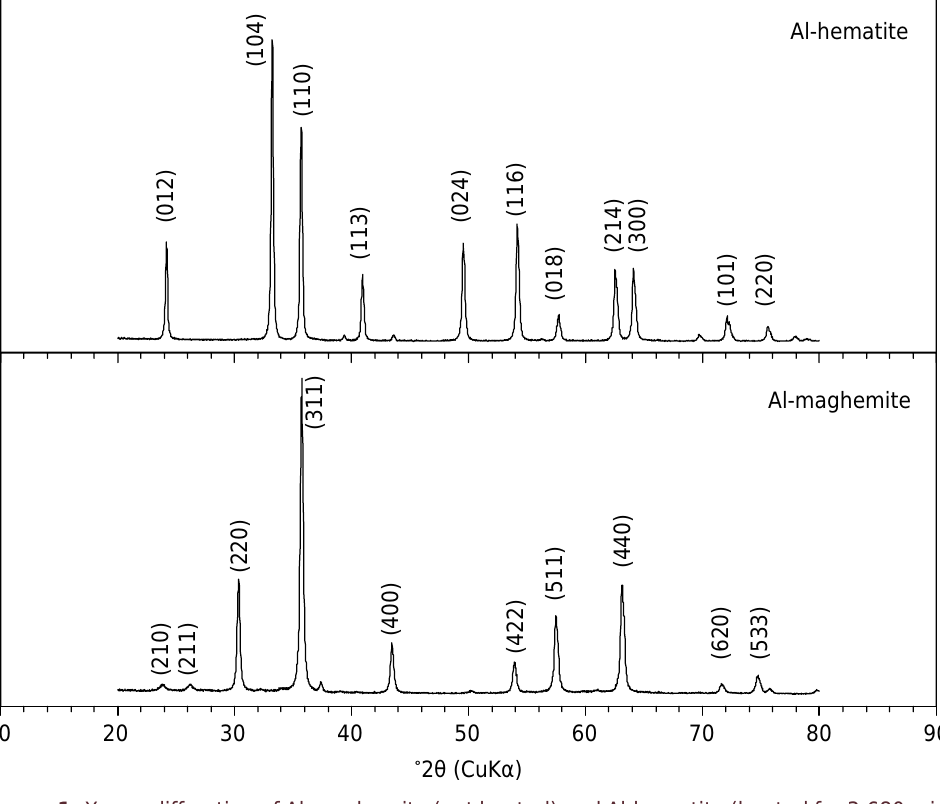
Figure 1. X rays diffraction of Al-maghemite (not heated) and Al-hematite (heated for 3,680 min) with 3.8 mol% Al.